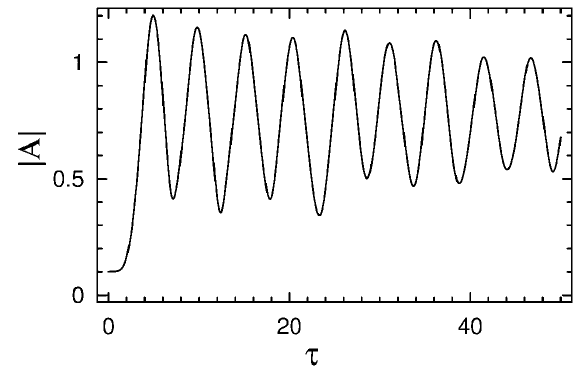
FIG. 2. The dependence of the amplitude j A j versus 0 in the nonlinear regime of the instability. After 0 ’ 1 , the exponen- tial growth of the linear regime changes to oscillations with the average amplitude j A j ’ 1 and the frequency of the oscil- lations ’ 1